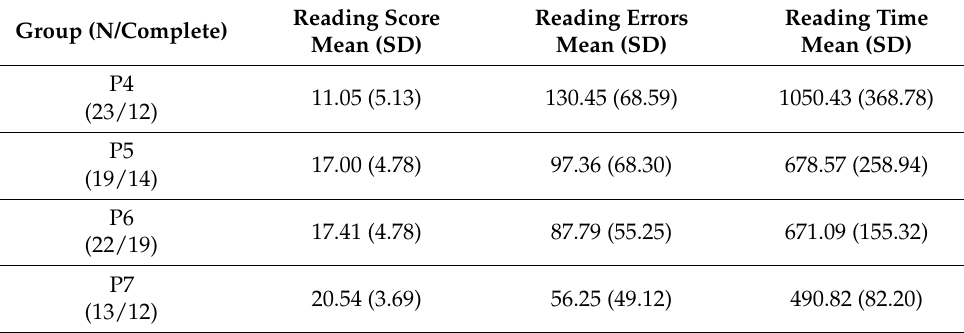
Table 1. Raw data on the Gaelic version of the Reading for All test across the three dimensions. Note that while the score includes all participants, the errors and speed numbers only include participants who completed the seven paragraphs of the test. Group